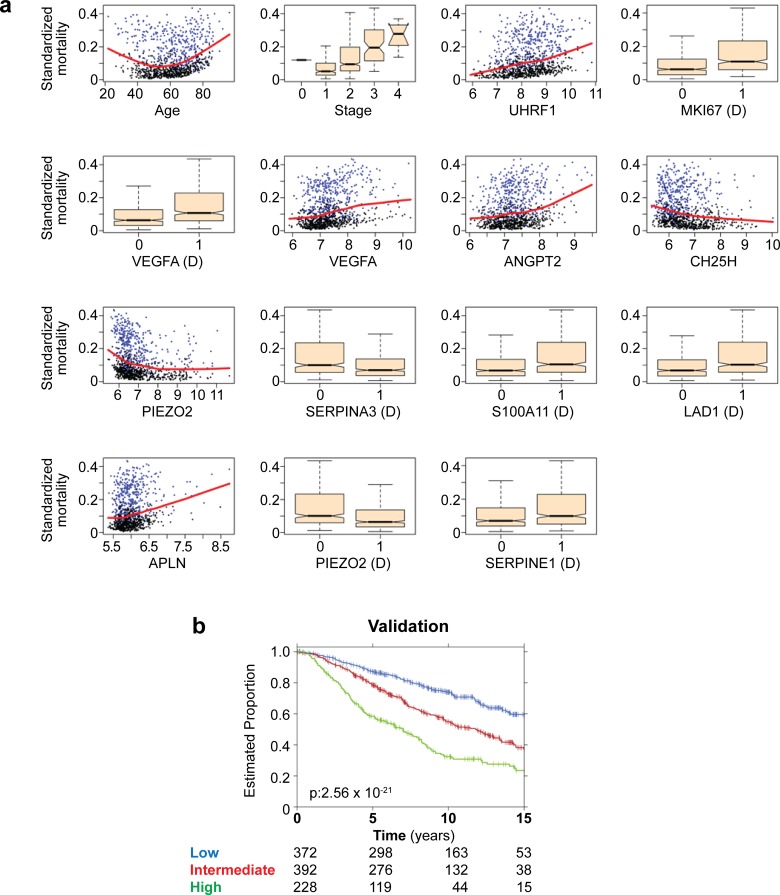
Machine learning and an angiogenesis signature with prognostic power.(a) Features used in gene signature. Patient’s age, stage of cancer and 13 (11 genes) expression-based features were used with Random Forest to build a signature for prediction of breast cancer relapse with D representing discretized (binary) expression values. (b) RandomForestSRC algorithm was trained on a dataset of 56 features (54 angiogenesis-induced genes plus age and tumor stage) using the METABRIC training cohort. The resulting classifier was applied on the validation cohort and was able to separate patients into three groups with significantly different outcomes. Low-risk (more than 15 years), intermediate-risk (between 15 and 7.5 years) and high-risk (less than 7.5 years).